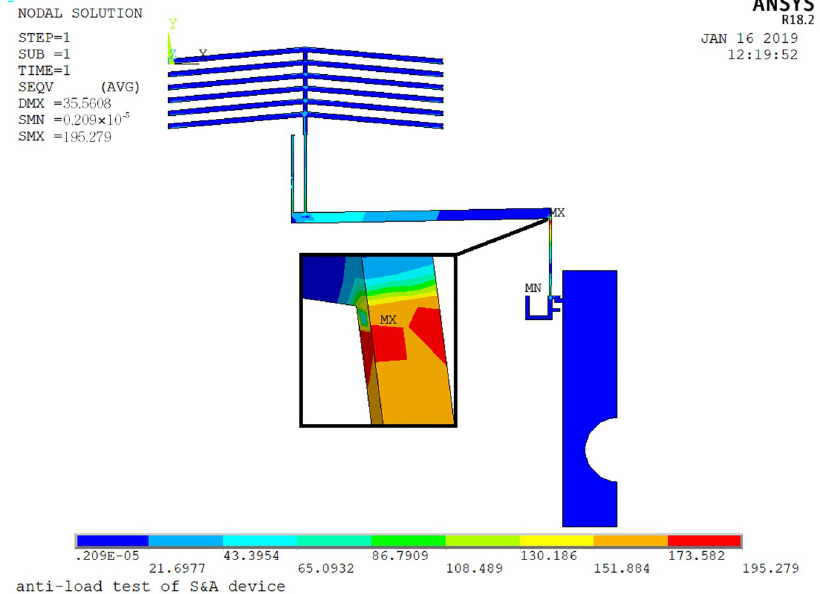
Figure 18. The maximum stress of the MEMS S&A device (20,000 g setback acceleration).